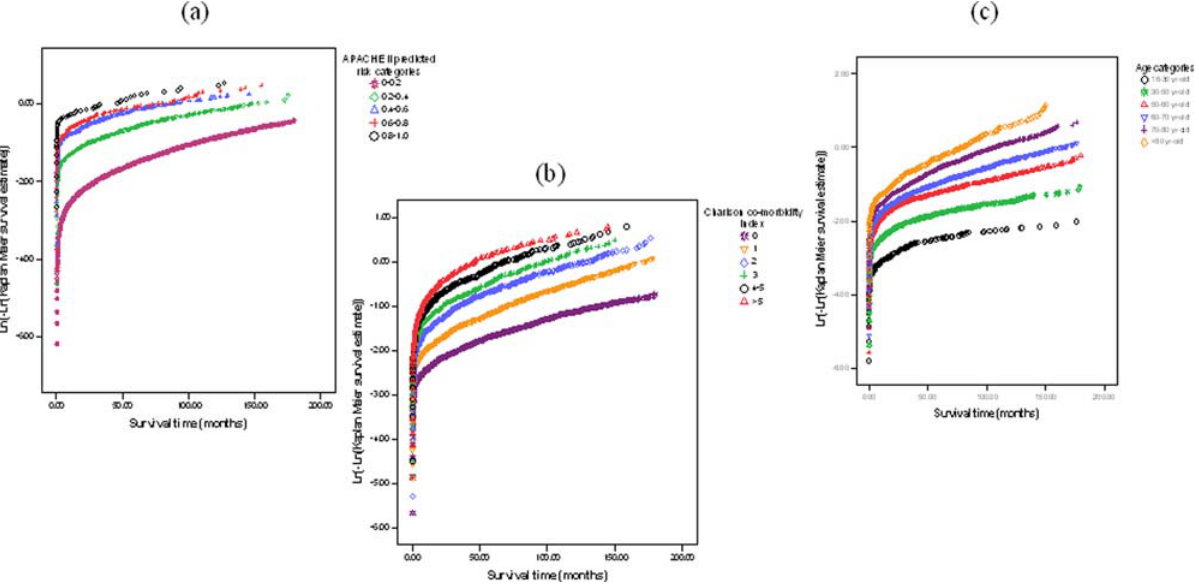
Figure 1. The proportional hazards assumption of the predictors in the Cox model was assessed by plotting the logarithm of the negative logarithm of the Kaplan Meier survivor estimates and the assumption was found to be acceptable for the three pre- selected continuous predictors; APACHE II predicted mortality, Charlson co-morbidity index, and age. (a) Graph assessing the proportionality of hazards associated with severity of acute illness measured by the APACHE II predicted mortality risk categories (0–20%, 20–40%, 40–60%, 60–80%, 80–100%). (b) Graph assessing the proportionality of hazards associated with co-morbidities measured by Charlson co-morbidity index categories (0, 1, 2, 3, 4–5, . 5). (c) Graph assessing the proportionality of hazards associated with age measured by age categories (16–30, 30– 50, 50–60, 60–70, 70–80, . 80 years old)